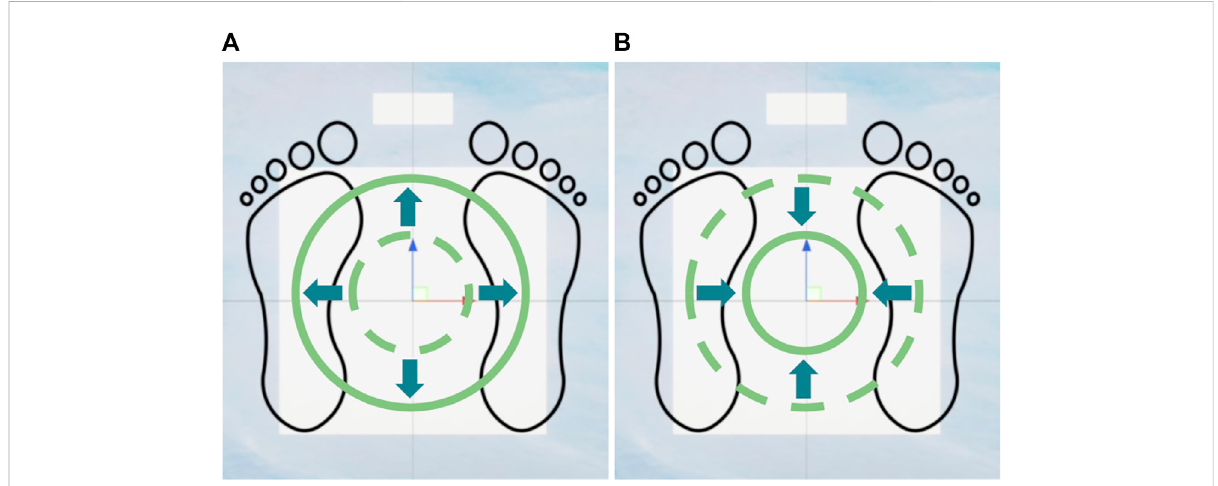
FIGURE 5 Ultrasound expanding ripple effect for jumping (A) and collapsing ripple effect for landing (B) .